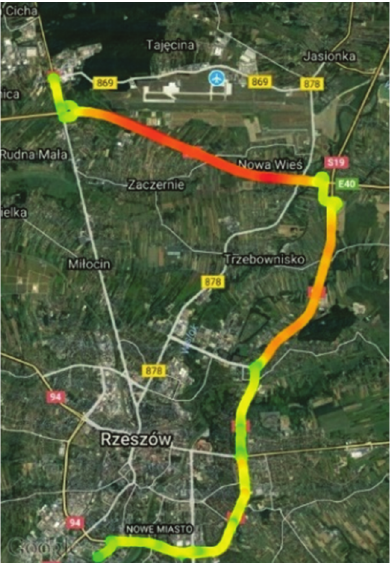
Fig, 1. Map with the selected stretch of road